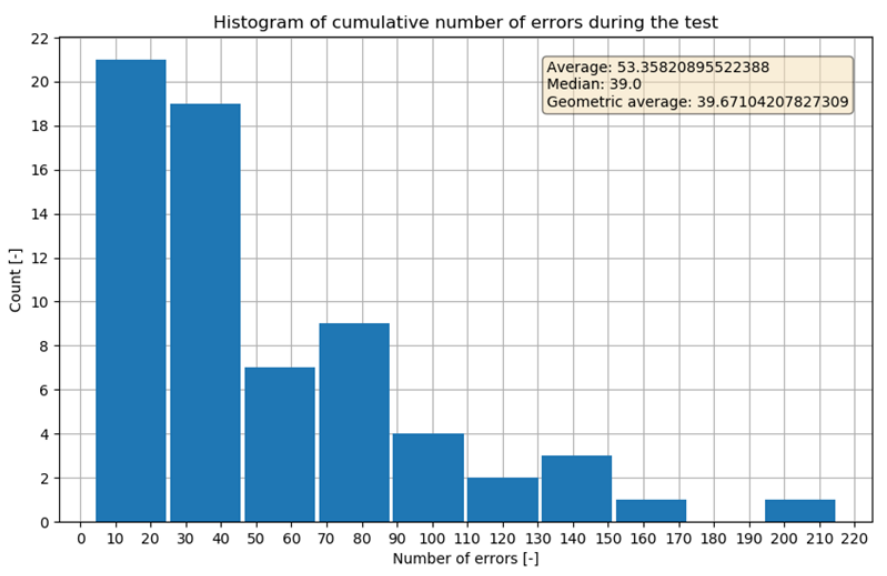
Figure 13. Histogram of the cumulative number of errors during the test.